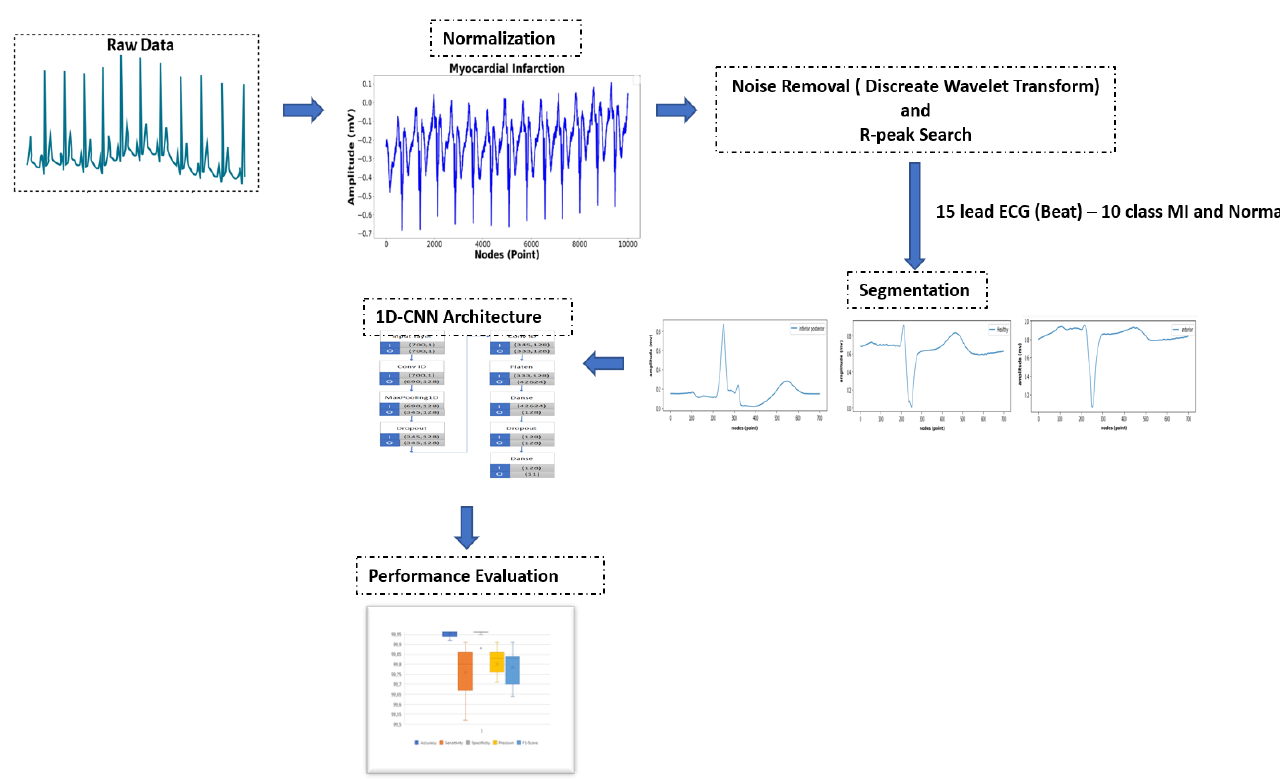
Table 1. The number of beats contained in the 15 lead ECG dataset